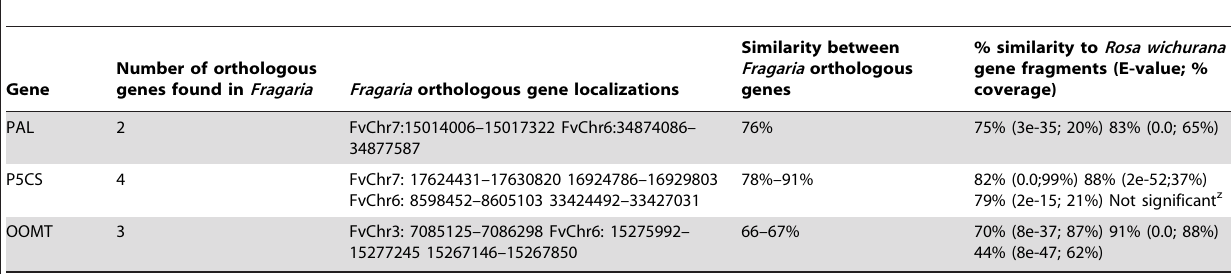
Table 4. Divergence among members of PAL , P5CS , OOMT orthologous genes of Fragaria and their similarity to Rosa wichurana gene fragments used in this study.